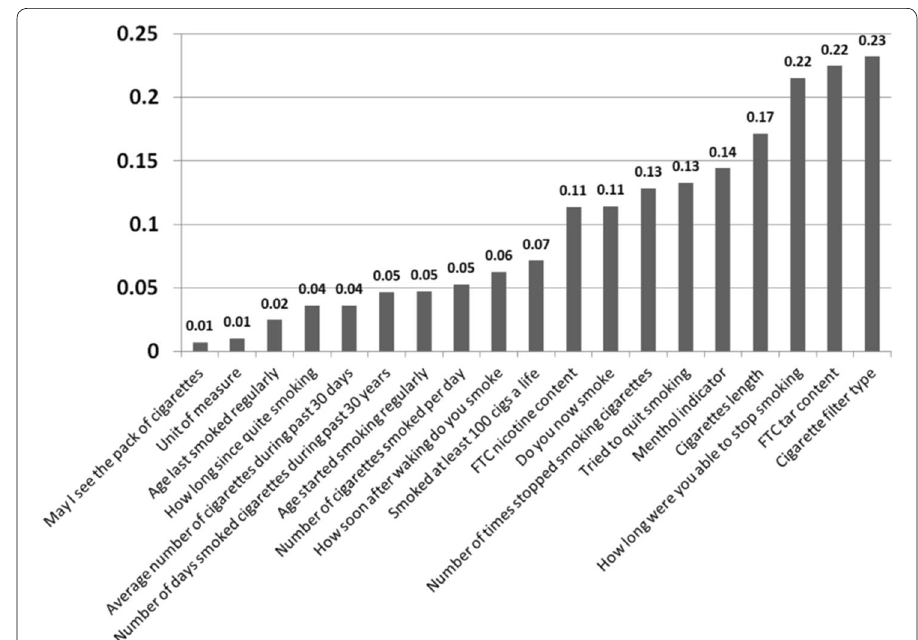
Fig. 11 Error rates in correlations for top imputations of SMQ data variables